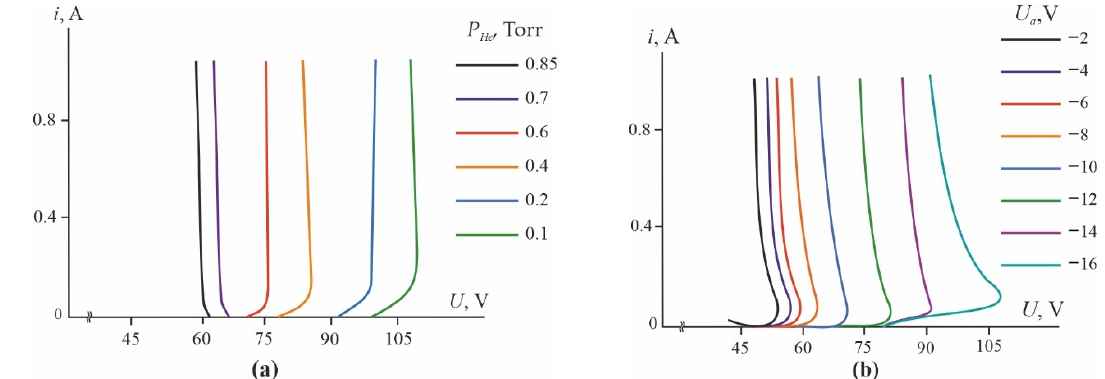
Figure 6. Current-voltage curves of the cathode—control electrode gap: ( a ) For different values of helium pressure; ( b ) For various negative potentials of the main anode U a and fixed pressure P He = 0.5 Torr.